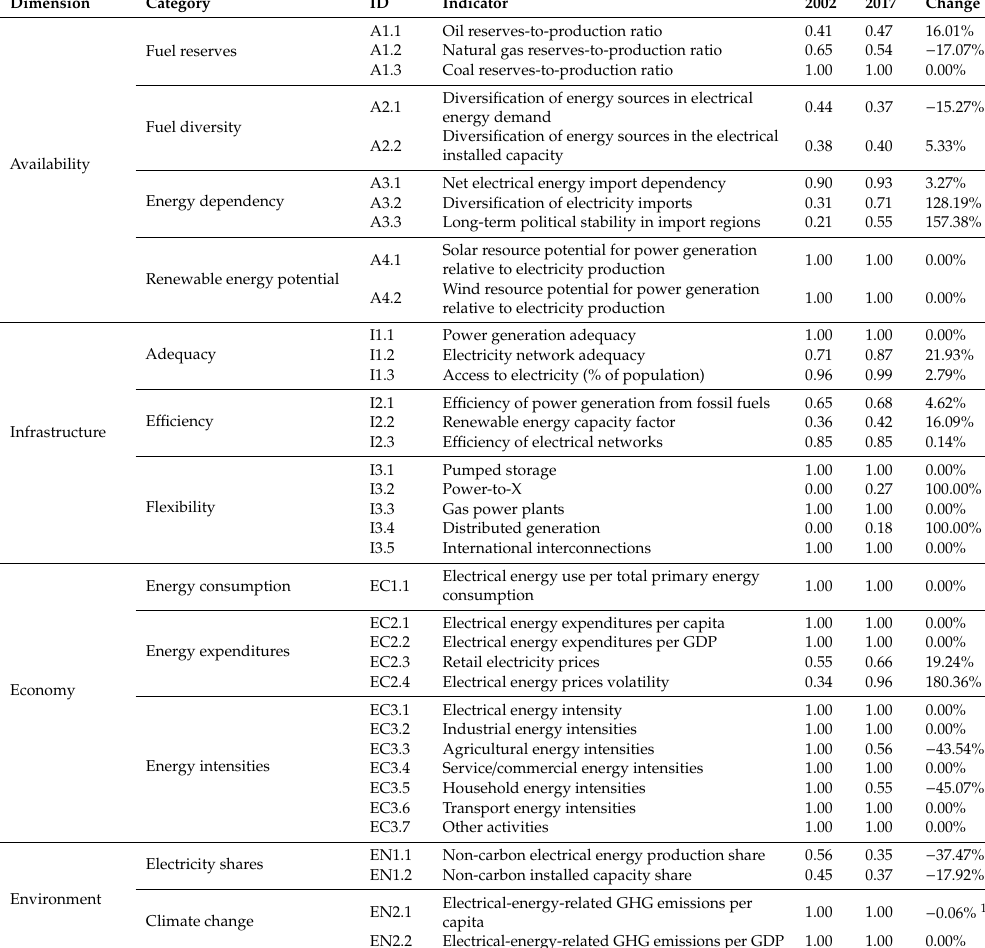
Table 2. Outcome of indicators in the Argentinean